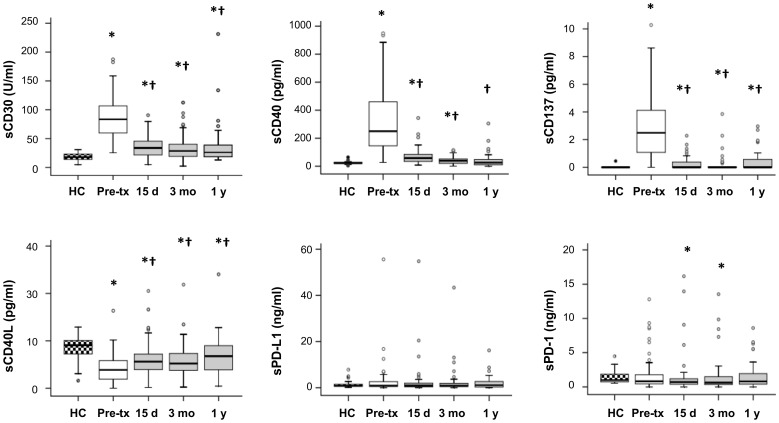
Modulation of soluble co-signaling molecules in kidney-transplanted patients over time.The levels of the soluble co-signaling molecules CD30, CD40, CD137, CD40L, PD-1 and PD-L1 were assayed by ELISA in serum samples of healthy controls (n = 25) and kidney-transplanted patients (n = 59) obtained at different times: just before transplantation, and 15 days, 3 months and 1 year after transplantation. Data are shown as box-plots, in which the horizontal line within each box represents the median, the bottom and top of each box represent the 25th and 75th percentiles, the bars represent the 10th and 90th percentiles and circles indicate outliers. Unpaired and paired Wilcoxon tests were used to compare distributions between independent and dependent groups, respectively. * indicates statistically significant differences between healthy controls and kidney-transplanted patient samples, and † indicates statistically significant differences between patients samples obtained at different pre- and post-transplantation times.